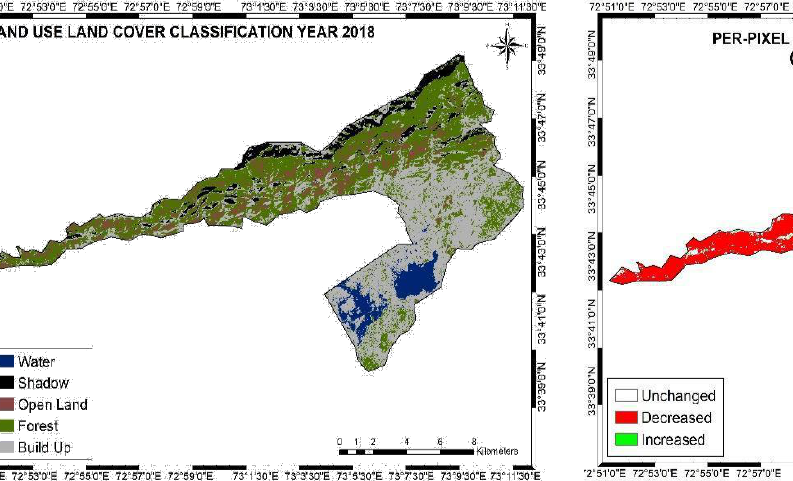
Figure 4: Per-Pixel Based Change Detection by applying Image Difference for year 2000 and 2018, Margalla Hills National Park (MHNP) Islamabad,